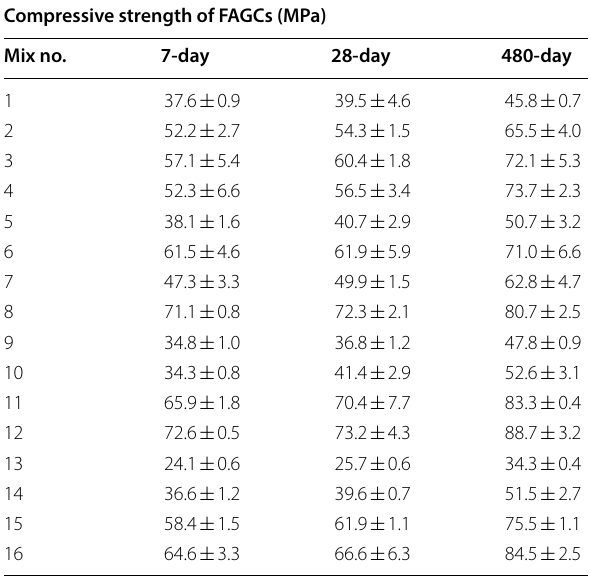
Table 6 Compressive strength of